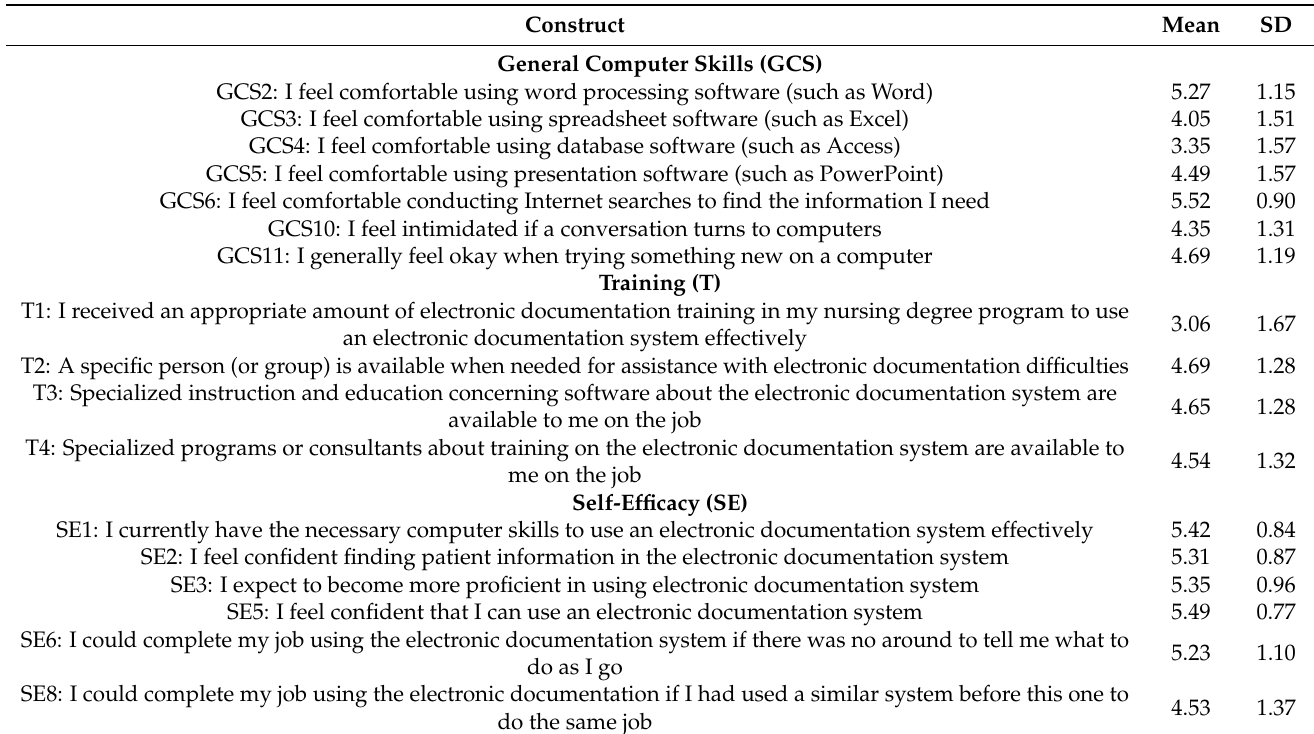
Table 5. Properties of items included under each construct.